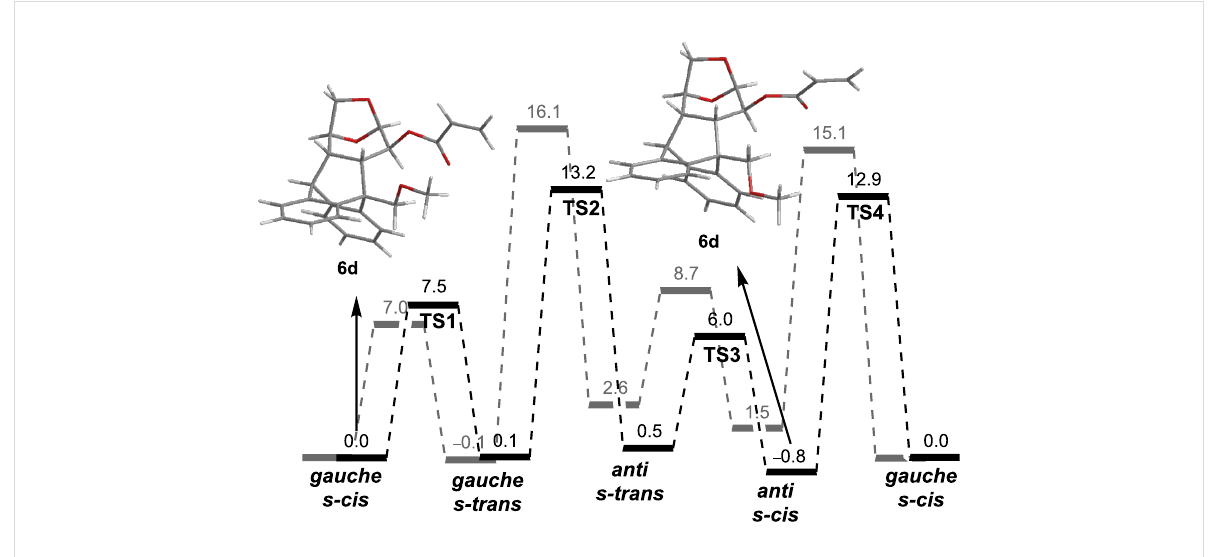
Figure 5: Comparison of the M06-2X/6-31+G(d) energy profiles (in kcal/mol) computed for 6d and 6b (in grey).